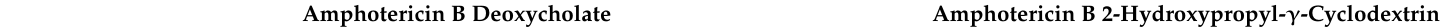
Table 2. Evolution over time of pH and osmolality for the amphotericin B deoxycholate and amphotericin B 2-hydroxypropyl- γ -cyclodextrin formulations. n = 4, mean ± standard deviation. Osmolality in mOsmol /